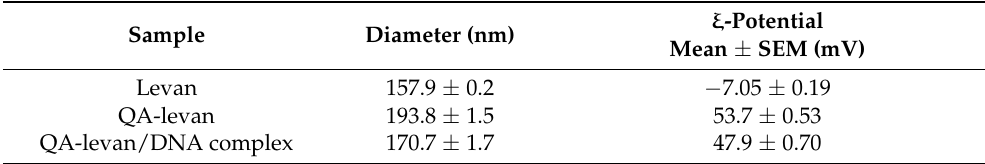
Figure 4. Particle size distribution of native levan, QA − levan and QA − levan/DNA polyplex deter- mined by dynamic light scattering (DLS). determined by dynamic light scattering (DLS). Table 2. Diameter and surface charge density of levan, QA-levan and polyplex. Table 2. Diameter and surface charge density of levan, QA-levan and